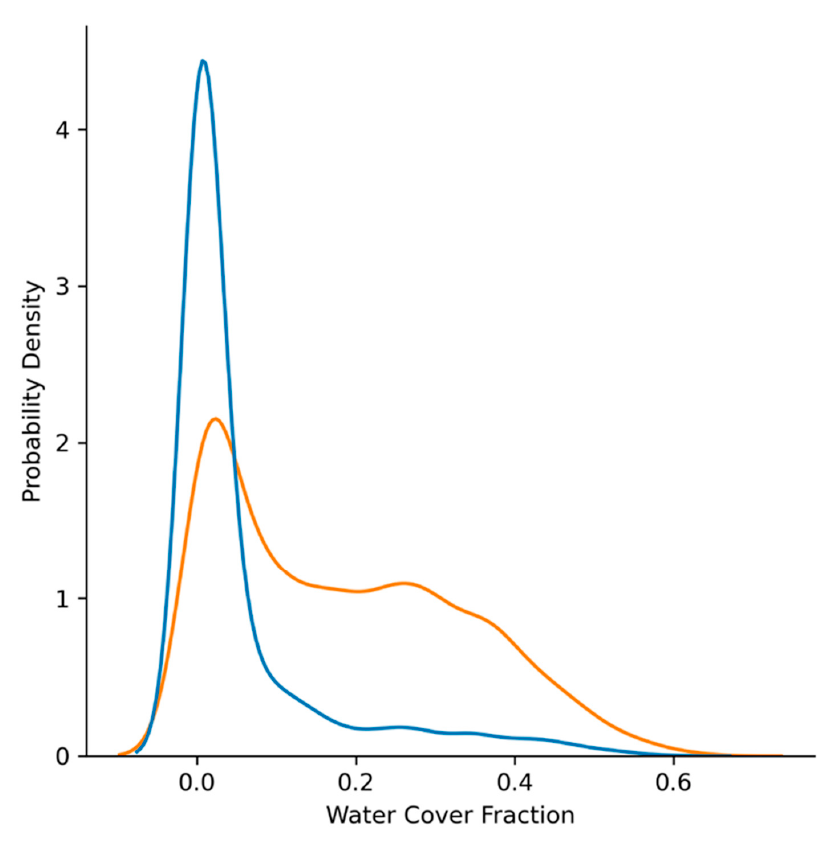
Figure 17. KDEs for fraction of Bay covered by lake/pond water and swamp/marsh water.